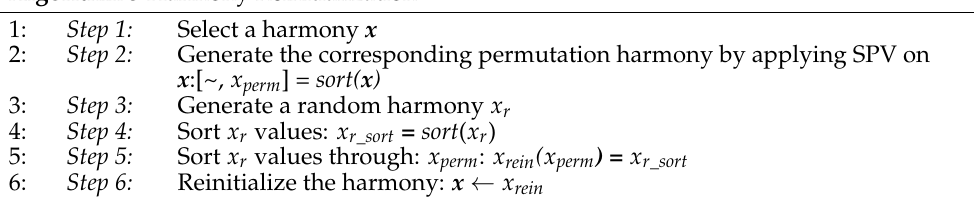
Algorithm 3 Harmony Reinitialization